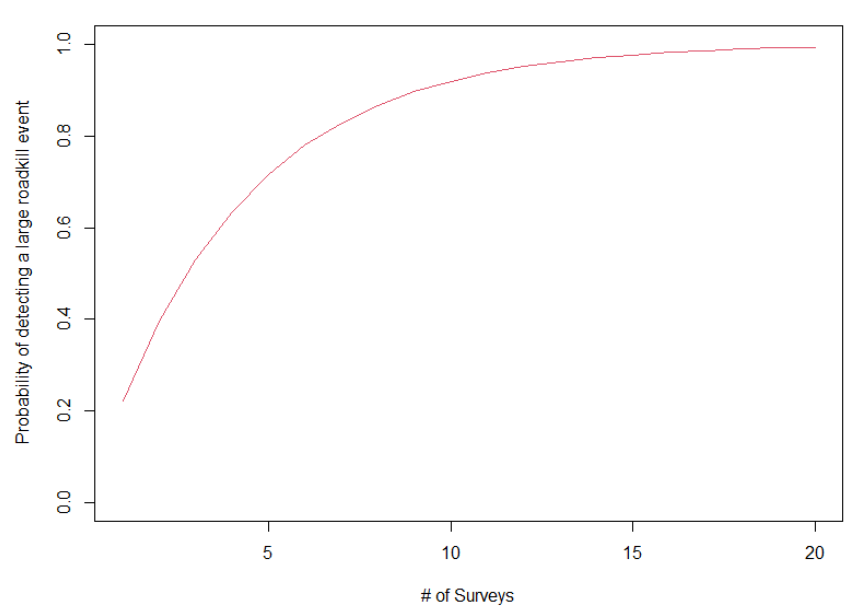
Figure 3. Number of surveys versus the probability of detecting at least one large roadkill event ( ≥ 5 amphibian or reptile carcasses) at occupied sites in Rhode Island, USA, 2019–2021.